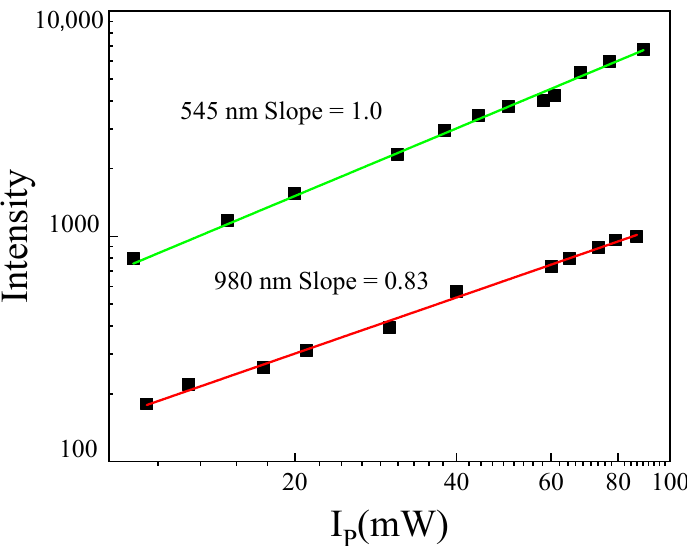
Figure 5. Plot of the Tb 3+ and Yb 3+ emission intensity as a function of pumping power (Ip) at 488 nm obtained in 2.5Tb 3+ -1Yb 3+ co-doped phosphate glass.